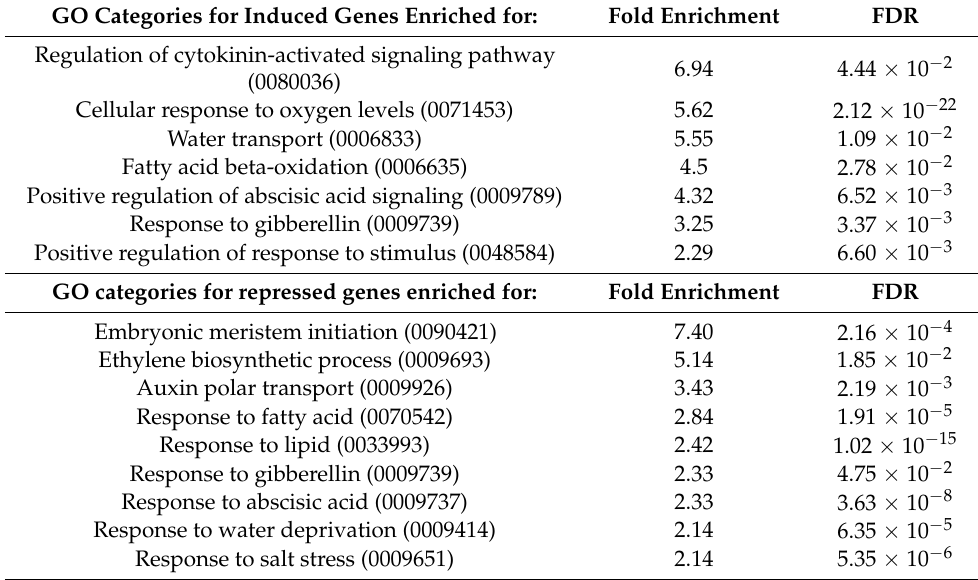
Table 2. GO enrichment analysis for the transcripts common in RNA-Seq and microarray studies that are upregulated and downregulated compared to Col, wt. The PANTHER classification system was used to discover significantly (FDR < 0.05) overrepresented categories. Fold enrichment compared the dataset to the whole Arabidopsis genome (release 16 November